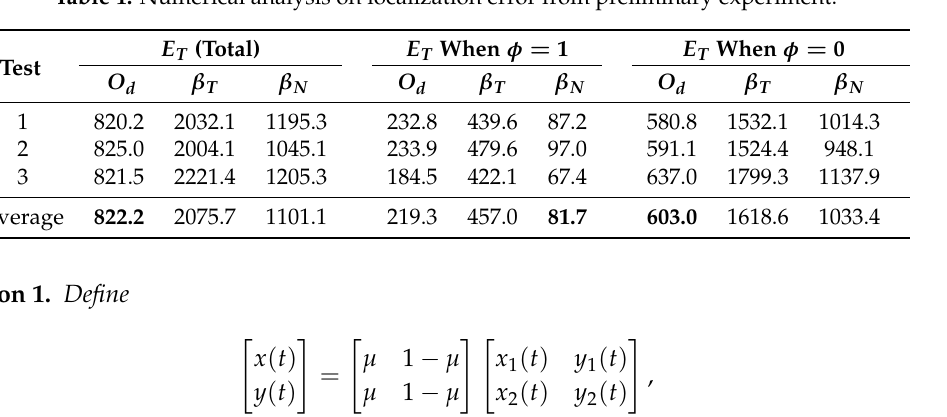
Table 1. Numerical analysis on localization error from preliminary experiment.